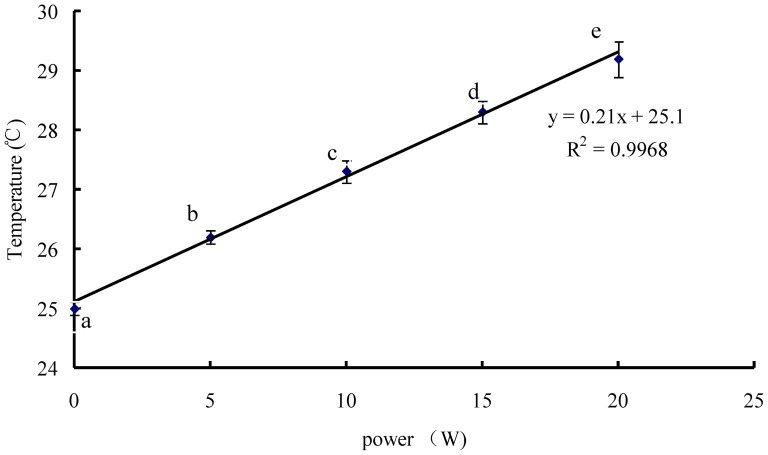
Temperature of 100 ml deionized water as a function of sonication power.